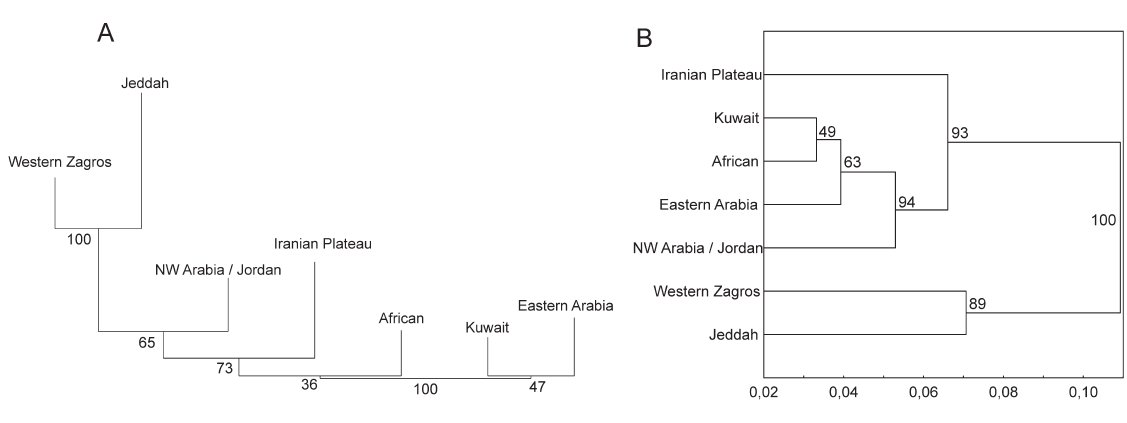
Fig. 8. Dendograms obtained from the (A) NJ clustering and (B) UPGMA, using Euclidean distances between group means by combining all data (shape information from dorsal, ventral and lateral views). Branch bootstrap support shown at the nodes, 10 000